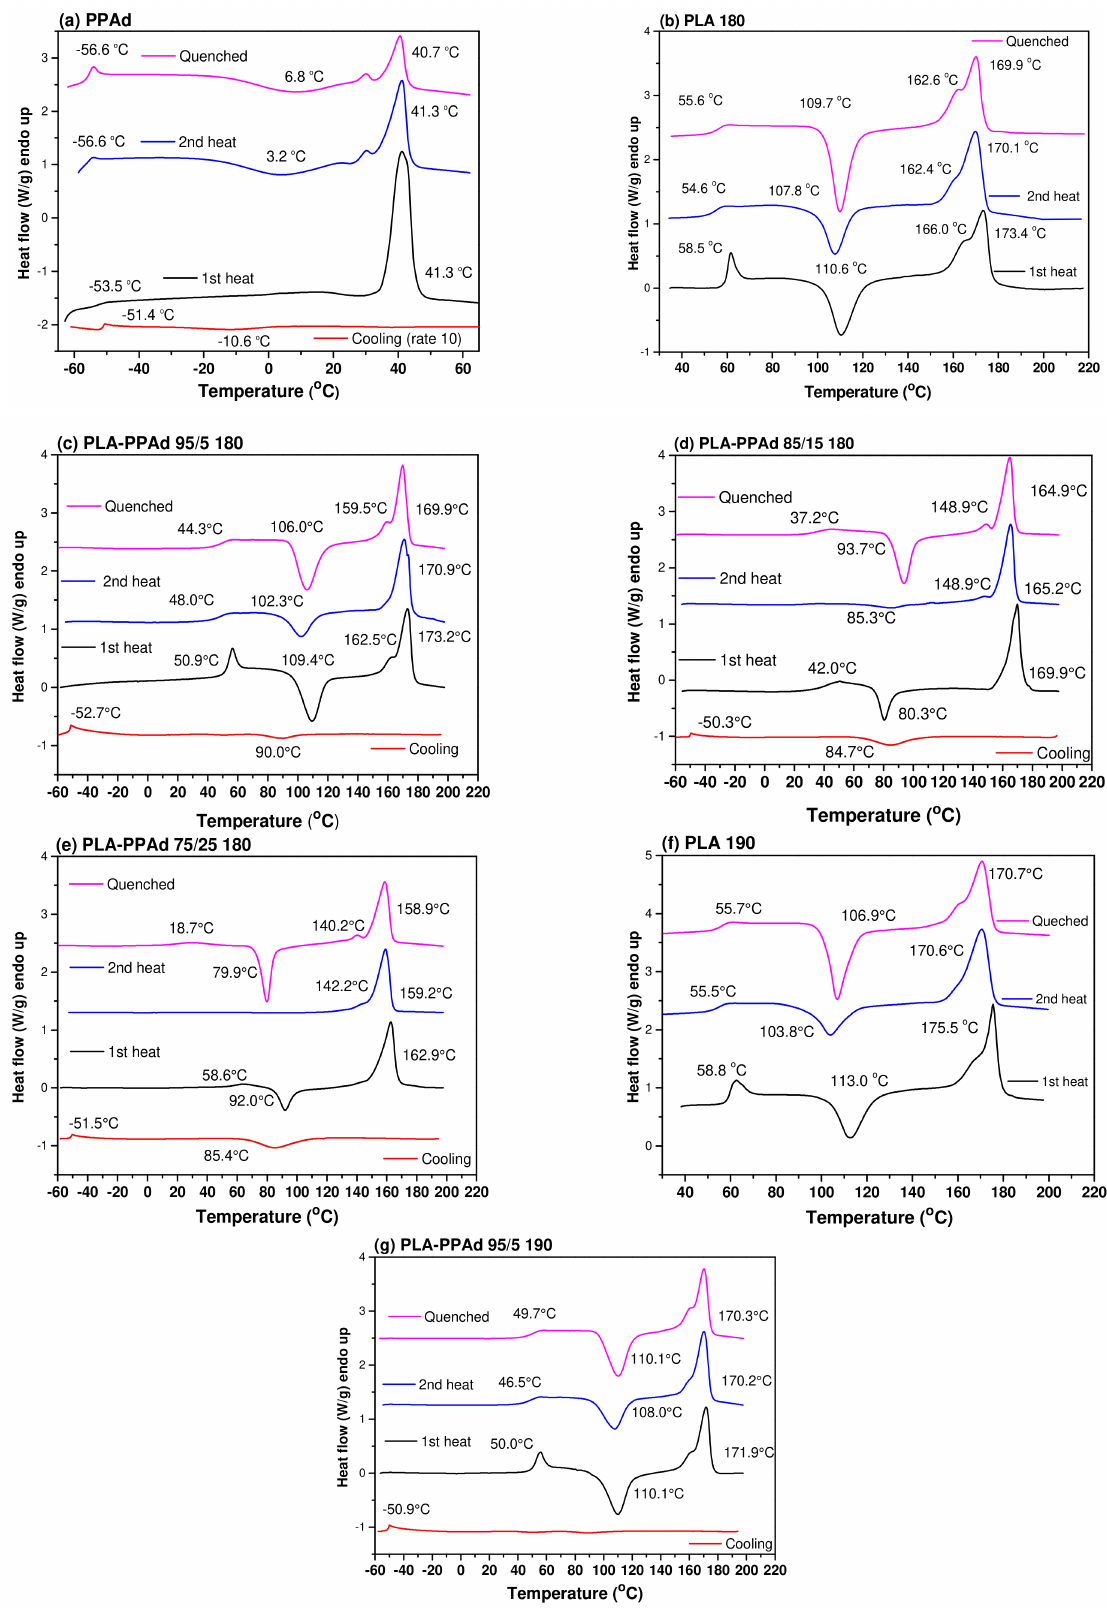
Figure 4. DSC traces of ( a ) PPAd, ( b ) PLA 180, ( c ) PLA 190, ( d ) PLA-PPAd 95/5 180, ( e ) PLA-PPAd 95/5 190, ( f ) PLA-PPAd 85/15 180, ( g ) PLA-PPAd 75/25